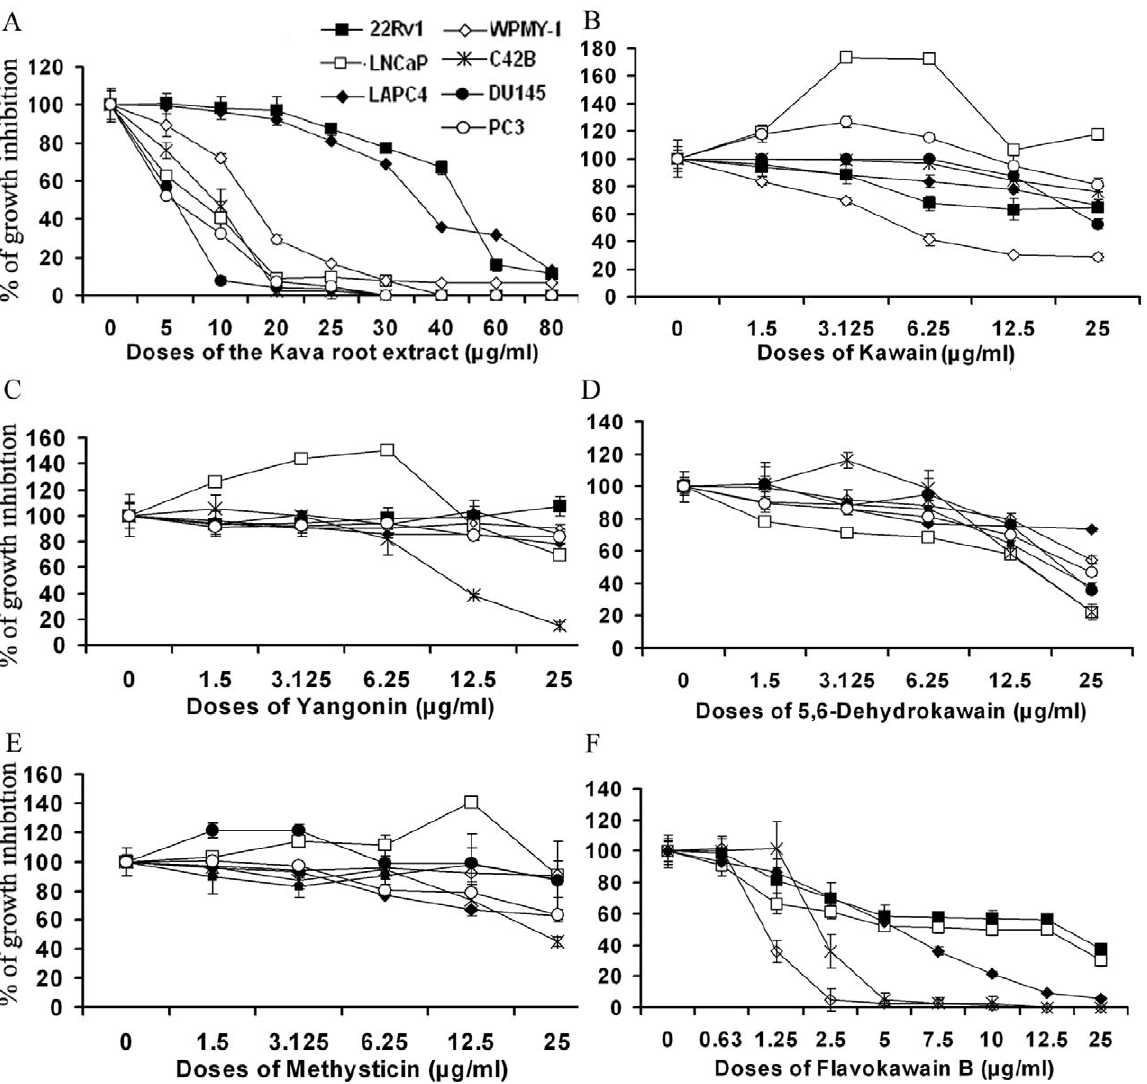
Figure 2. The effect of the kava root extract and its active components on the growth of PCa cell lines (C4-2B, LNCaP, 22Rv1, LAPC- 4, DU145 and PC3) and a prostate myofibroblast WPMY-1. Cells in 24-well culture plates were treated with 0.1% DMSO, the kava root extract, kawain, 5 9 , 6 9 -dehydrokawain, yangonin, methysticin, or flavokawain B (FKB) at the indicated doses. After 72 hours of treatment, cell densities were measured by MTT assay. Each point is the mean of values from four independent plates; bars, SD. Each sample was counted in duplicate. IC 50 s were estimated by dose-response curves.